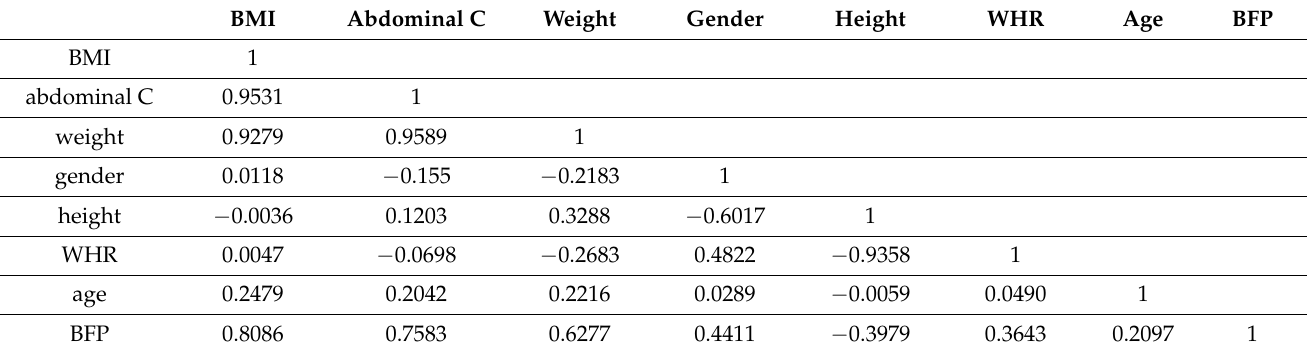
Table 2. Coefficients of correlation matrix between the